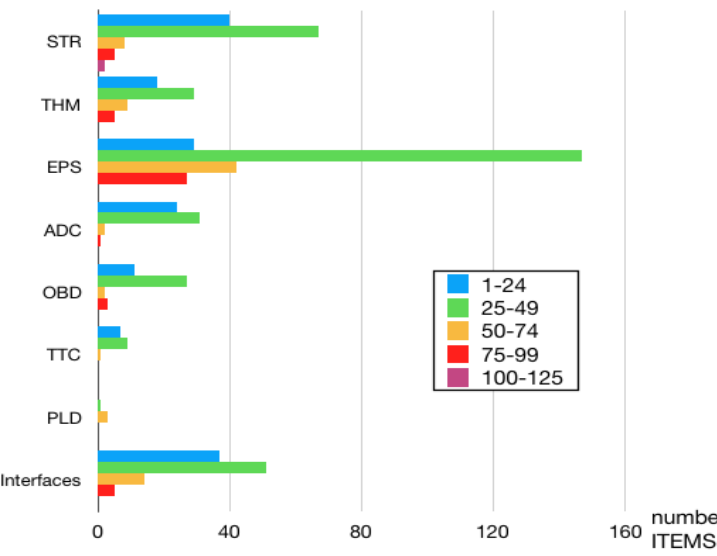
Figure 7. Distribution of RPN scores for each subsystem.